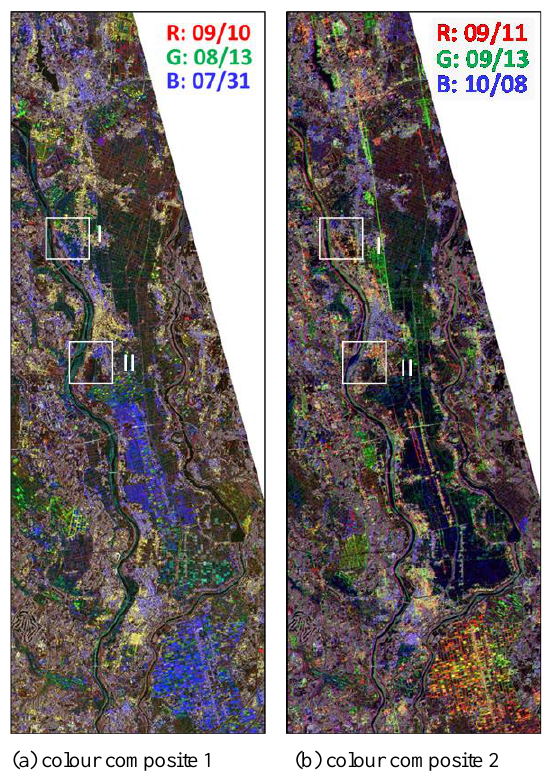
Figure 3. Multi-temporal colour composites of PALSAR-2 images for different combinations